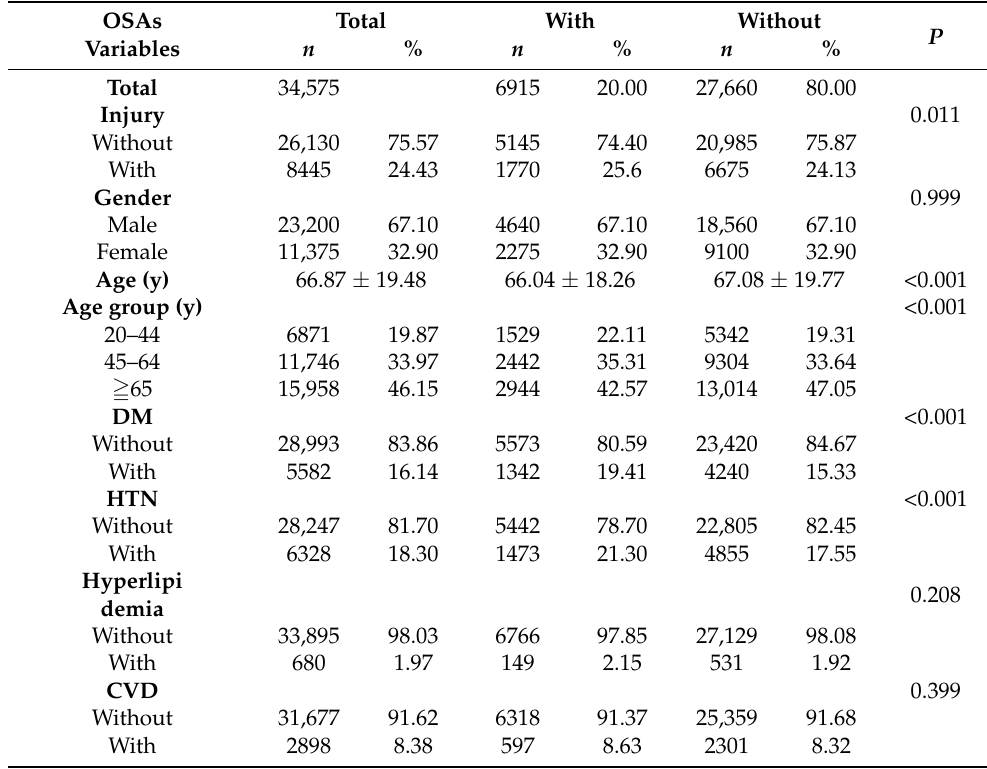
Table 1. Endpoint characteristics of the